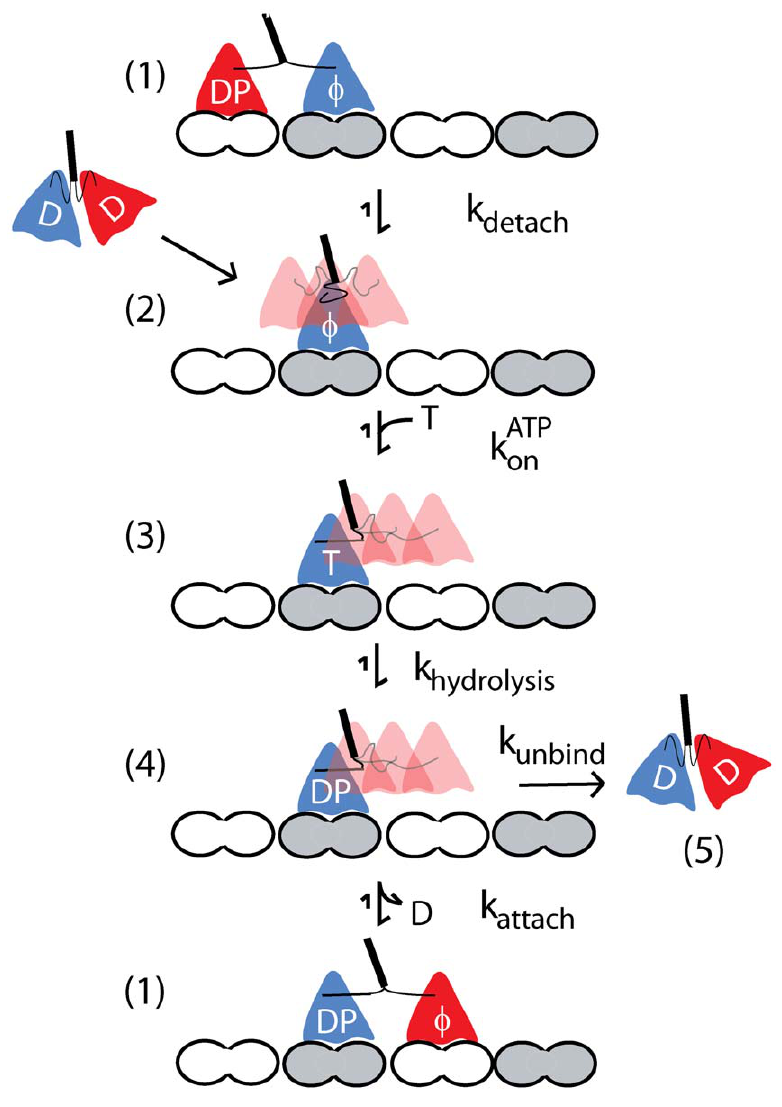
Figure 1. Kinesin Chemomechanical Pathway. Working model for the Kinesin-1 chemomechanical pathway based on previous experimental work. Nucleotide abbreviations are as follows: T=ATP, D=ADP, DP=ADP.Pi, w =No nucleotide. For clarity, ADP bound to tethered head in states 2–4 is not shown. In State 2 the tethered head diffuses, tethered by both neck linker domain, while in states 3 and 4 the neck linker domain of the bound head is docked, leading to a displacement of the tethered head towards the next binding site. State 5 represents motor detachment. Note that the number of steps per interaction (motor processivity) can be approximated by k attach /k unbind .